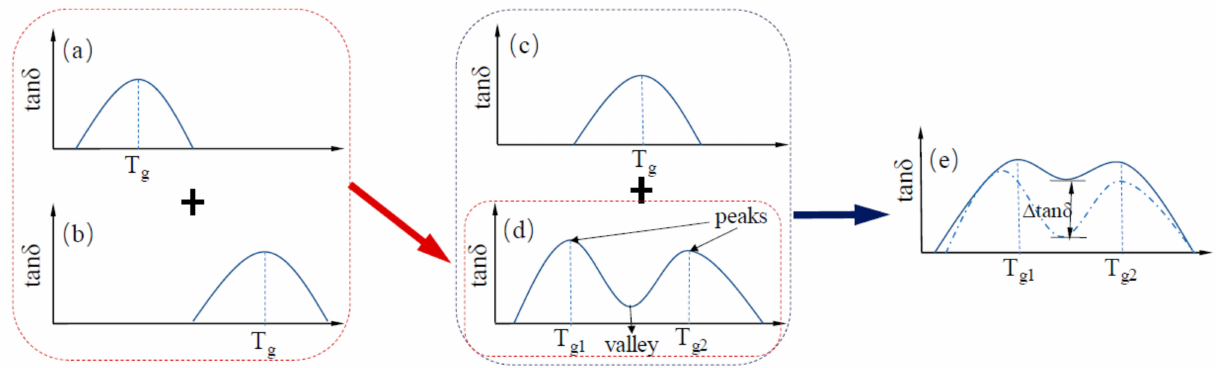
Figure 7. Schematic representation of the variation in the damping loss factor of rubber blends with respect to the temperature: ( a – c ) shows the dynamic mechanical analysis (DMA) temperature spectrum of each rubber component, respectively and ( d , e ) shows the broadening of the effective damping temperature range of the rubber blends